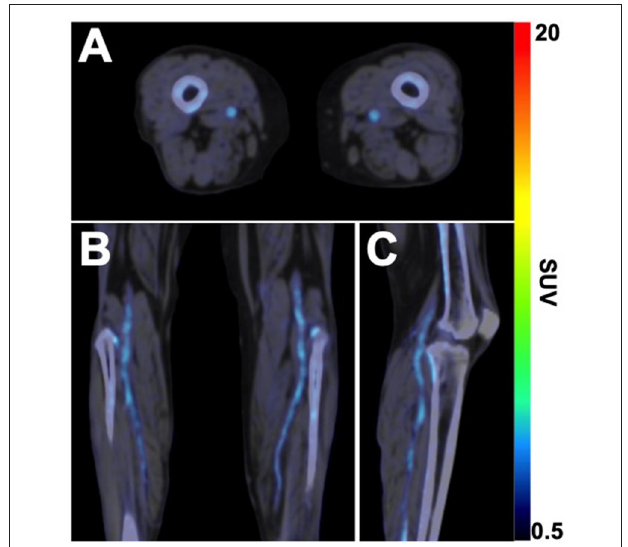
FIGURE 2 | 18 F-NaF PET/CT imaging of active microcalcification in PAD. (A) Axial, (B) coronal, and (C) sagittal fused 18 F-NaF PET/CT images acquired in a 63-year old female patient with CLTI and type 2 diabetes mellitus demonstrates the active process of microcalcification in above- and below-the-knee arteries. Non-contrast CT images were acquired for attenuation correction of PET data, followed by static PET imaging of the lower extremities 75min after intravenous administration of 18 F-NaF (296 MBq). SUV, standardized uptake